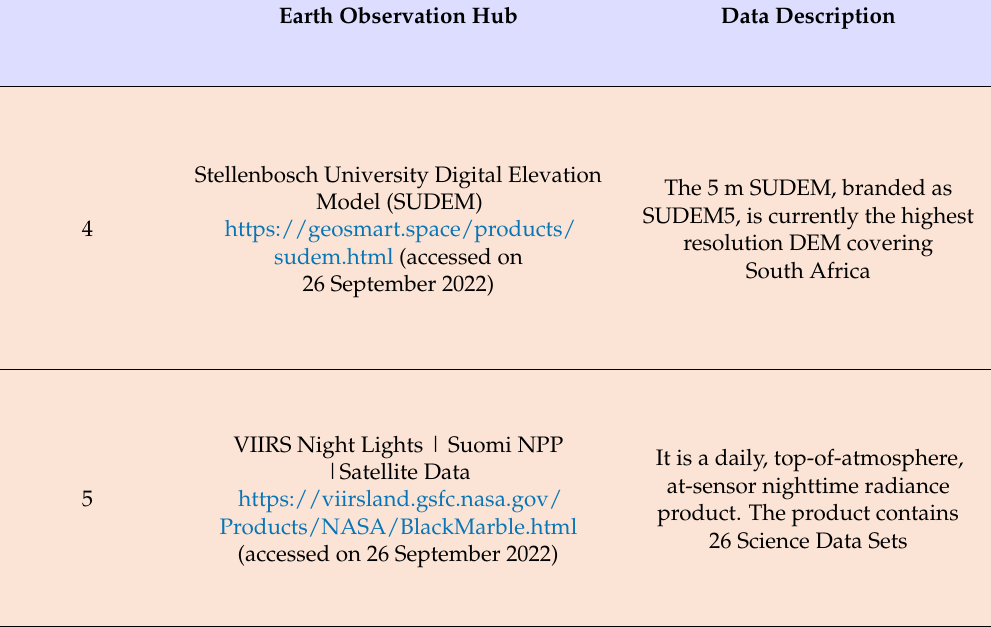
Table 4. Publicly available dataset for spatially referenced demographic studies.